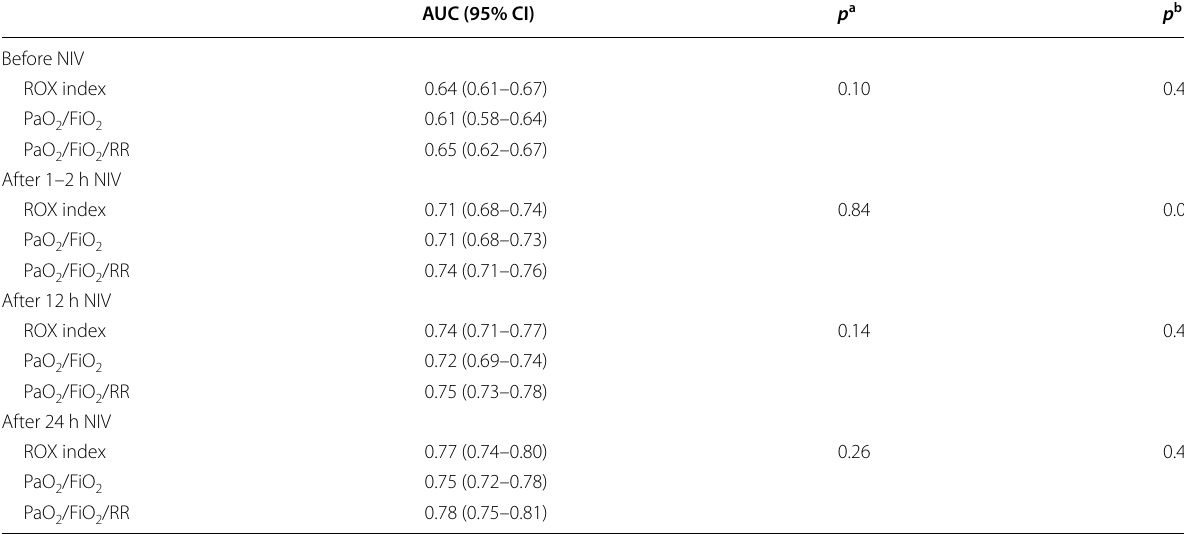
/FiO , and PaO /FiO 2 2 2 2